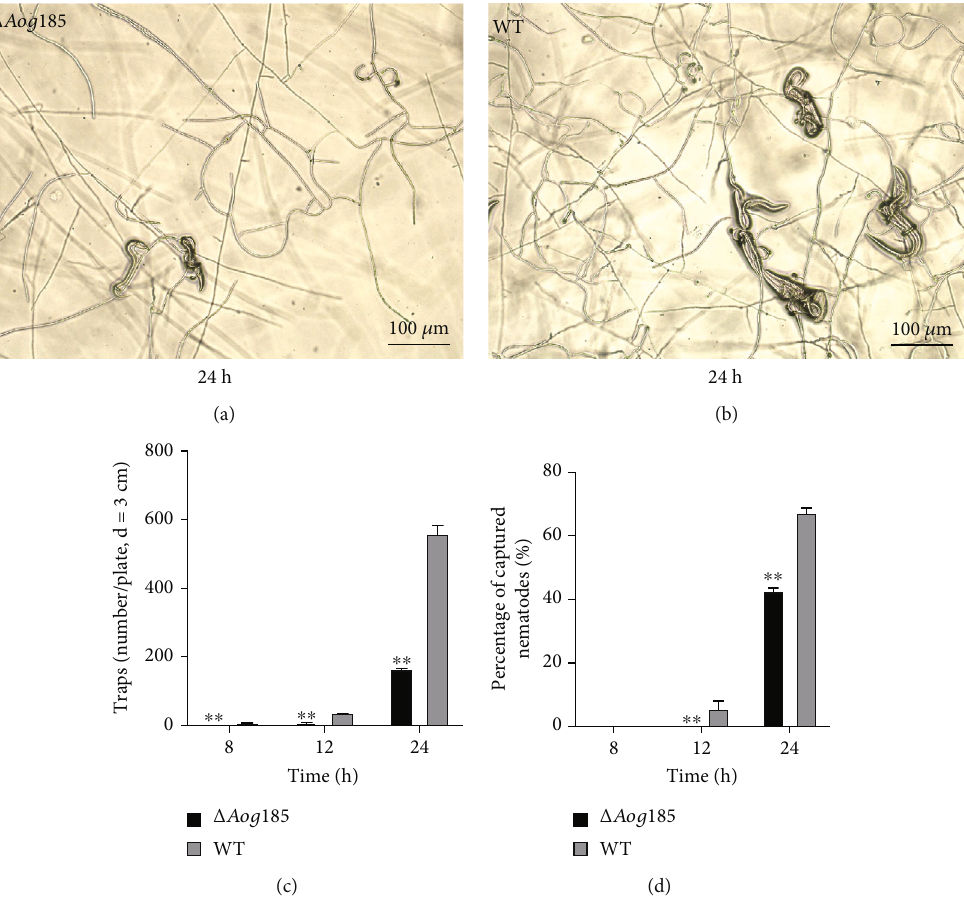
Figure 3: Comparisons of trap formation and nematicidal activities between the WT and Δ Ao g185 mutant strains. (a, b) Representative images of the trap formation and nematode trapping of the WT and Δ Ao g185 mutant strains after addition of nematodes for 24 h. (b) The numbers of nematode-induced traps generated by the WT and Δ Ao g185 mutant strains after addition of nematodes for 8, 12, and 24 h. (c) The percentages of nematodes captured by the WT and Δ Ao g185 mutant strains after addition of nematodes for 8, 12, and 24h. ∗ p < 0 : 05 and ∗∗ p < 0 : 01